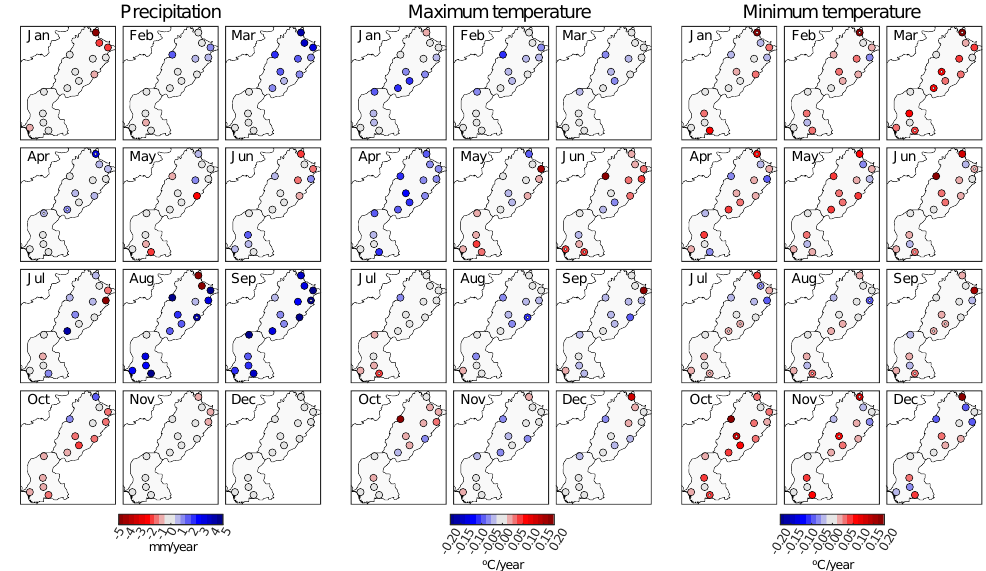
Figure 4. Observed annual trends in precipitation, maximum and minimum temperature (panels from left to right ) over the period 1997–2016 for each of the twelve calendar months. Significant (95% confidence level) trends are marked with a white